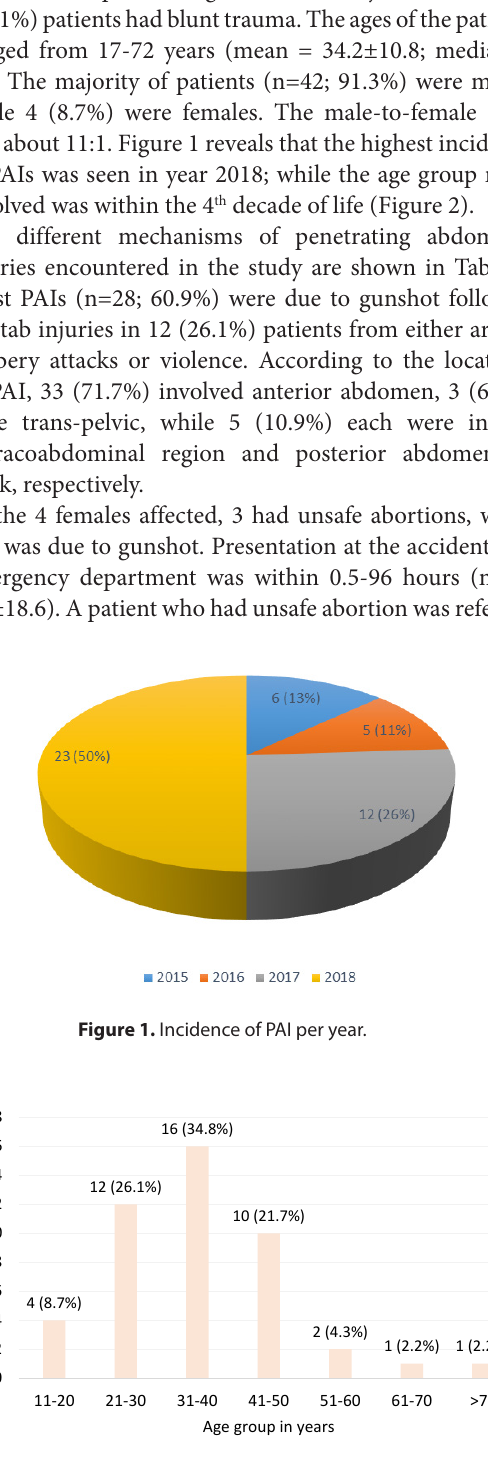
Figure 2. Age distribution of